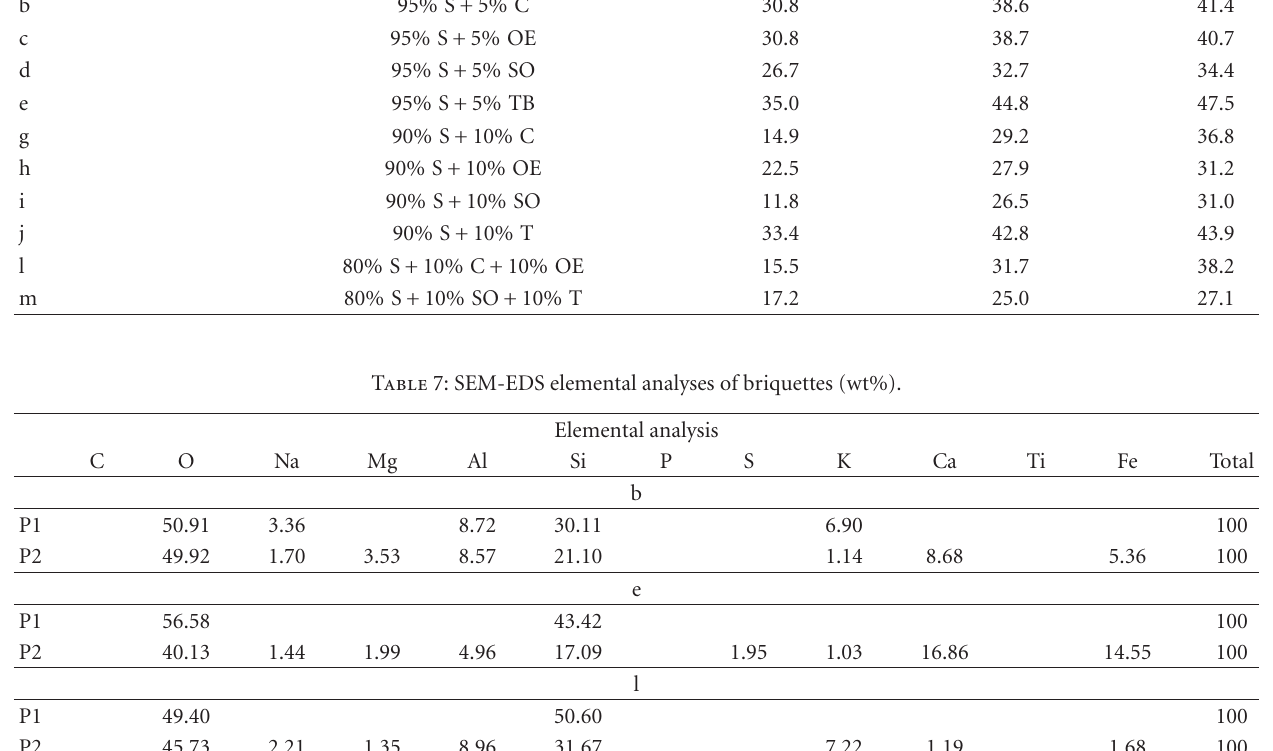
Table 6: Mixing ratios of the materials and average compressive strength values of briquettes. Sample code